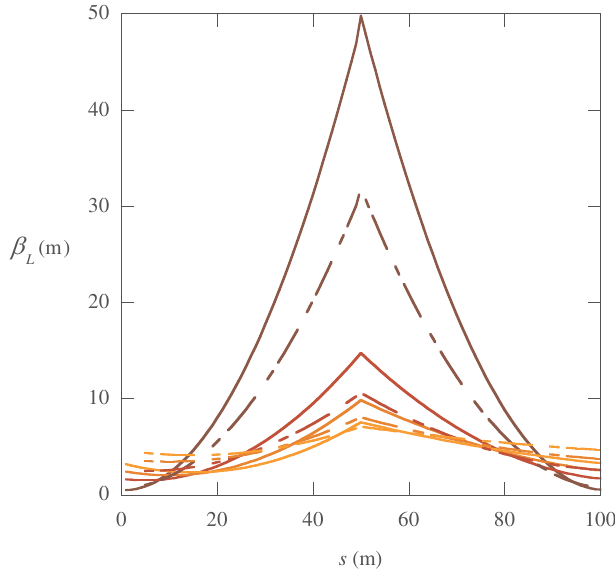
FIG. 7. (Color) Longitudinal beta function for case B. Full lines (cid:6) 7 : 5 MV , dashed ones to V correspond to V rf highest modulation corresponds to the smaller value of (cid:1) the different colors to the four values of (cid:1)